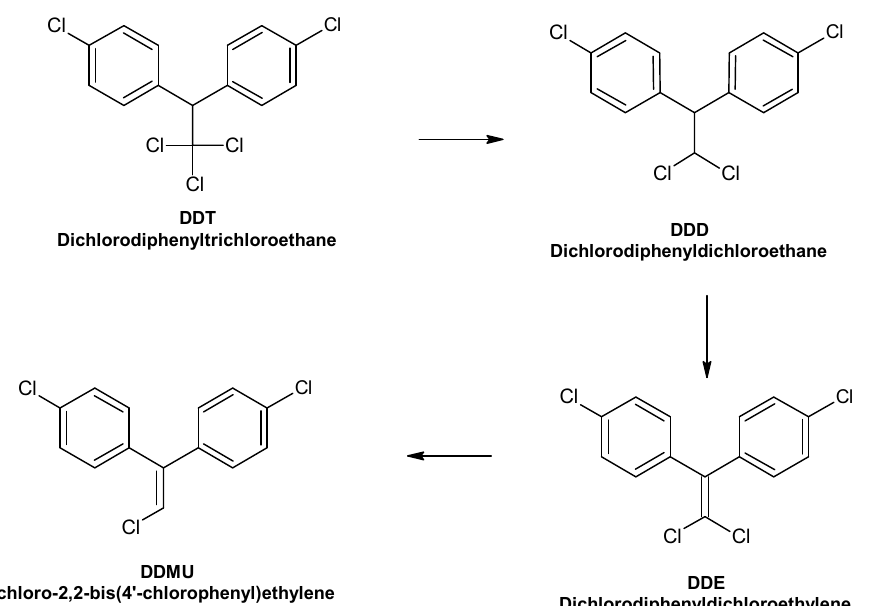
Figure 4. Proposed degradation pathway of DDT by the co-culture of brown-rot fungus Fomitopsis pinicola and the bacterium Ralstonia pickettii [216].